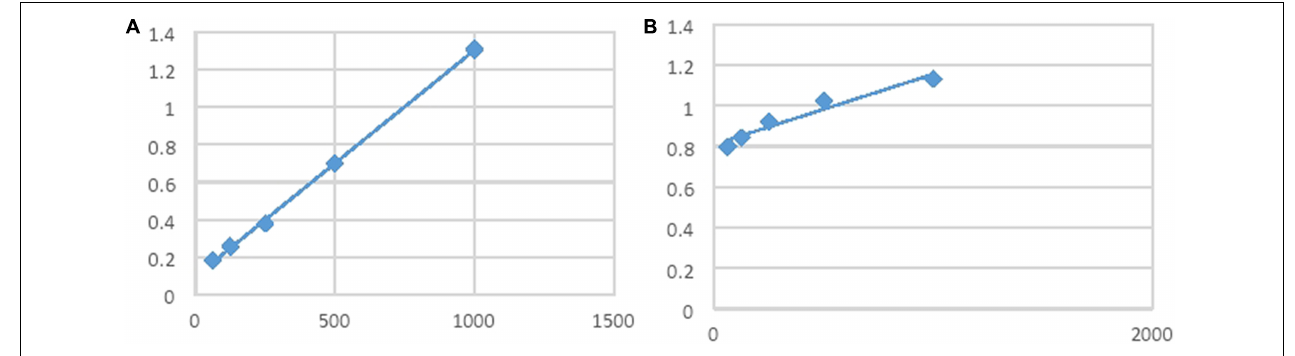
FIGURE 3 | (A) Total phenolic content. (B) Total flavonoid content.